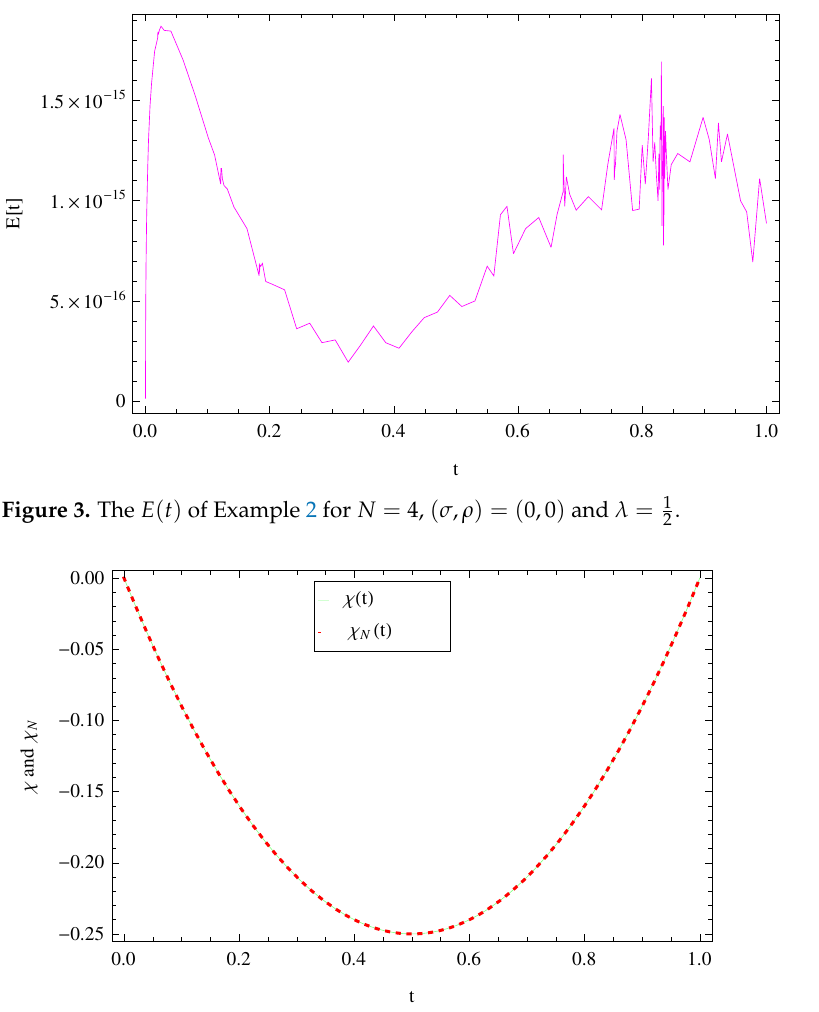
Figure 4. The approximate and the exact solutions, χ N ( t ) and χ ( t ) , of Example 2 for N = 4, ( σ , ρ ) = ( 0,0 ) and λ = 1 2